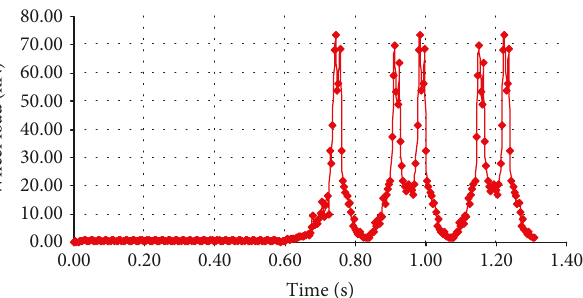
Figure 13: Wheel load versus time curve.